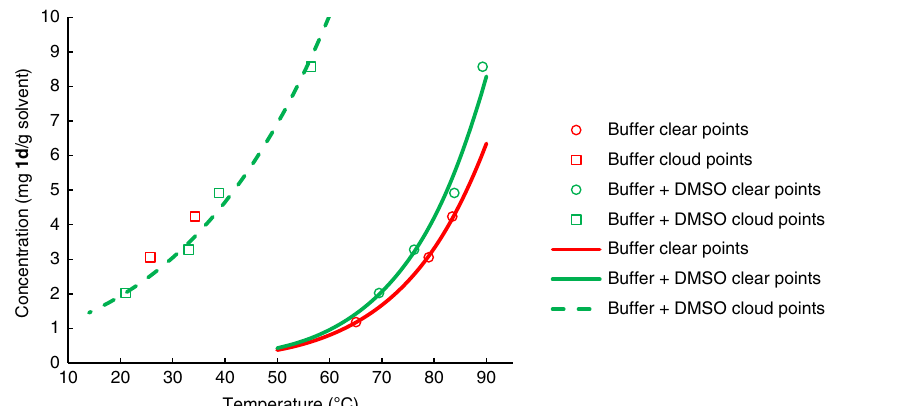
Fig. 5 Determination of the solubility of adipaldehyde dioxime ( 1d ). The solubility tests were conducted in presence or absence of DMSO in the reaction medium by heating the suspension containing 1d and successive cooling of